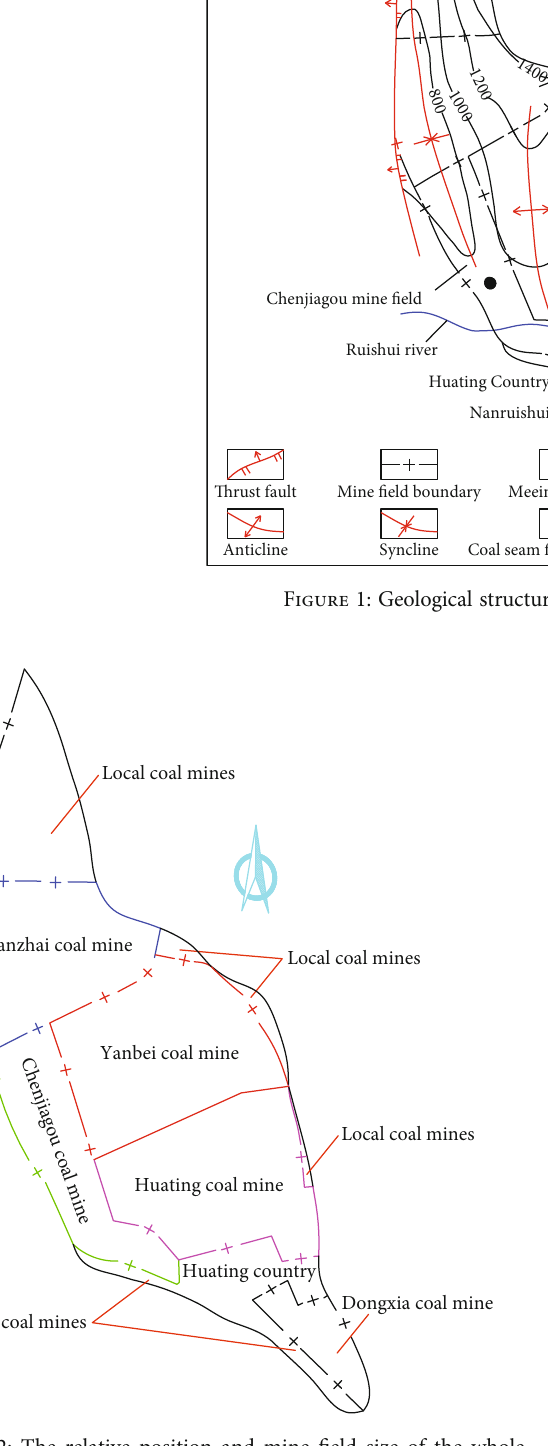
Figure 2: The relative position and mine fi eld size of the whole Huayan mine fi